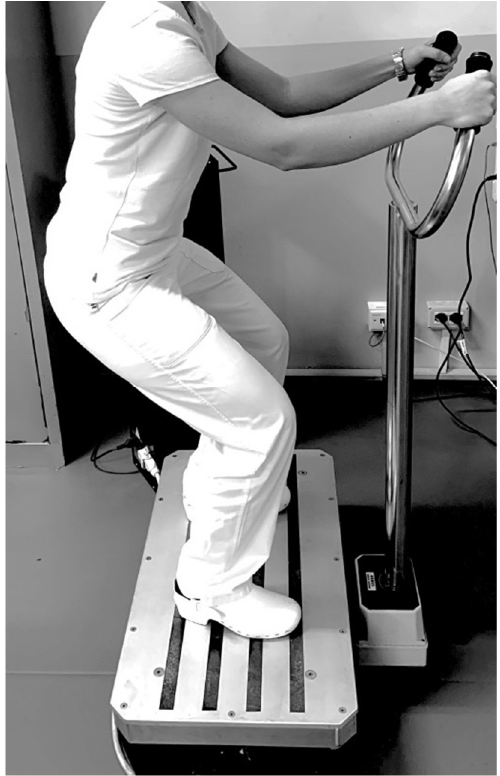
Figure 2. Example of physical exercise plus whole ‐ body vibration. Group B (physical exercise plus sham WBV) performed 5 sets of 10 repetitions of squats without WBV alternating with 5 sets of 30 s on WBV platform (model NEMES ‐ LB Bosco System ® , Rieti, Italy), with sham treatment and no frequency (0 Hz) in an isometric squat (110° of knee flexion).